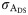
Ignoring SGE leads to biased estimates of DGE (heritability) in the outbred mice dataset.(A,B) DGE estimates for all organismal phenotypes. The colour of the dots indicates the sign of the covariance σADS between DGE and SGE (blue: negative; red: positive; see Methods); the intensity of the colour indicates the magnitude of SGE. (A) Comparison of DGE estimates from model with DGE only (x-axis) and full model with DGE, SGE, (y-axis). (B) Comparison of DGE estimates from model with DGE and cage effects (x-axis) and full model (y-axis). (C) Difference between estimated and simulated DGE. The contribution of SGE to simulated phenotypes varied and is shown on the x-axis. See Methods for values given to other parameters. Simulations were analyzed with three different models: DGE only (red), DGE + cage effects (green), DGE + SGE + cage effects + social environmental effects (blue).